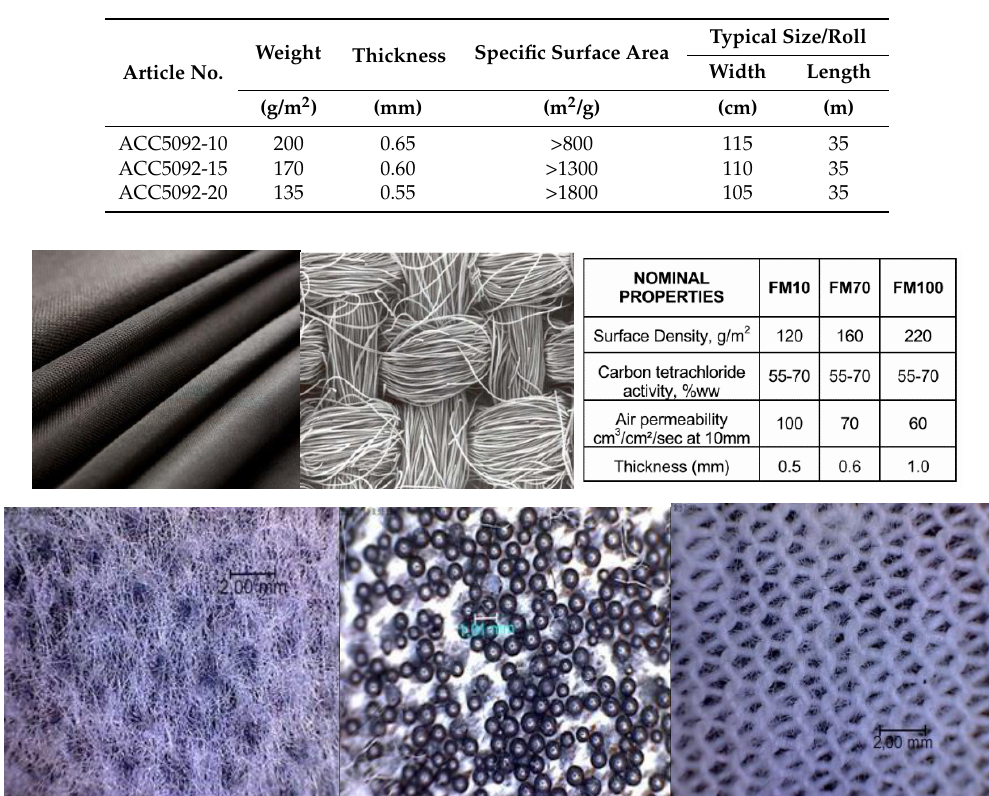
Figure 5. The view of cloth activated carbon cloths (ACC) 509215, from activated carbon fibers. Experimental breakthrough curves of toluene by various number of layers at C 0 = 500 p.p.m. toluene (left), and for five various concentrations Reproduced from [34]. Table 1. Basic parameters of Kynol cloths from activated carbon fibers.